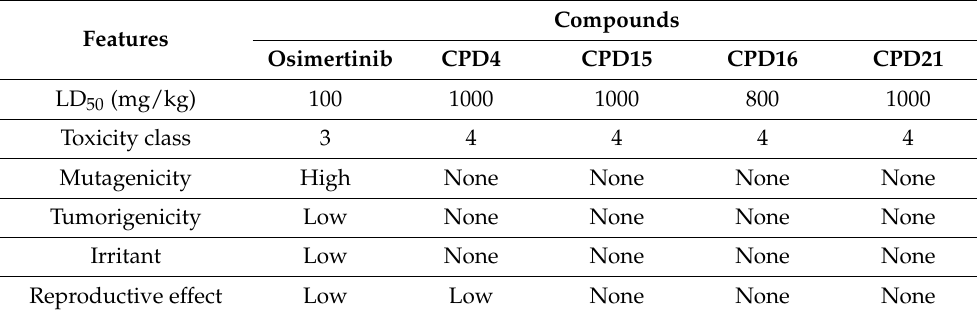
Table 2. Prediction of the main toxicity features of all screened quinoxalinones in comparison to osimertinib.